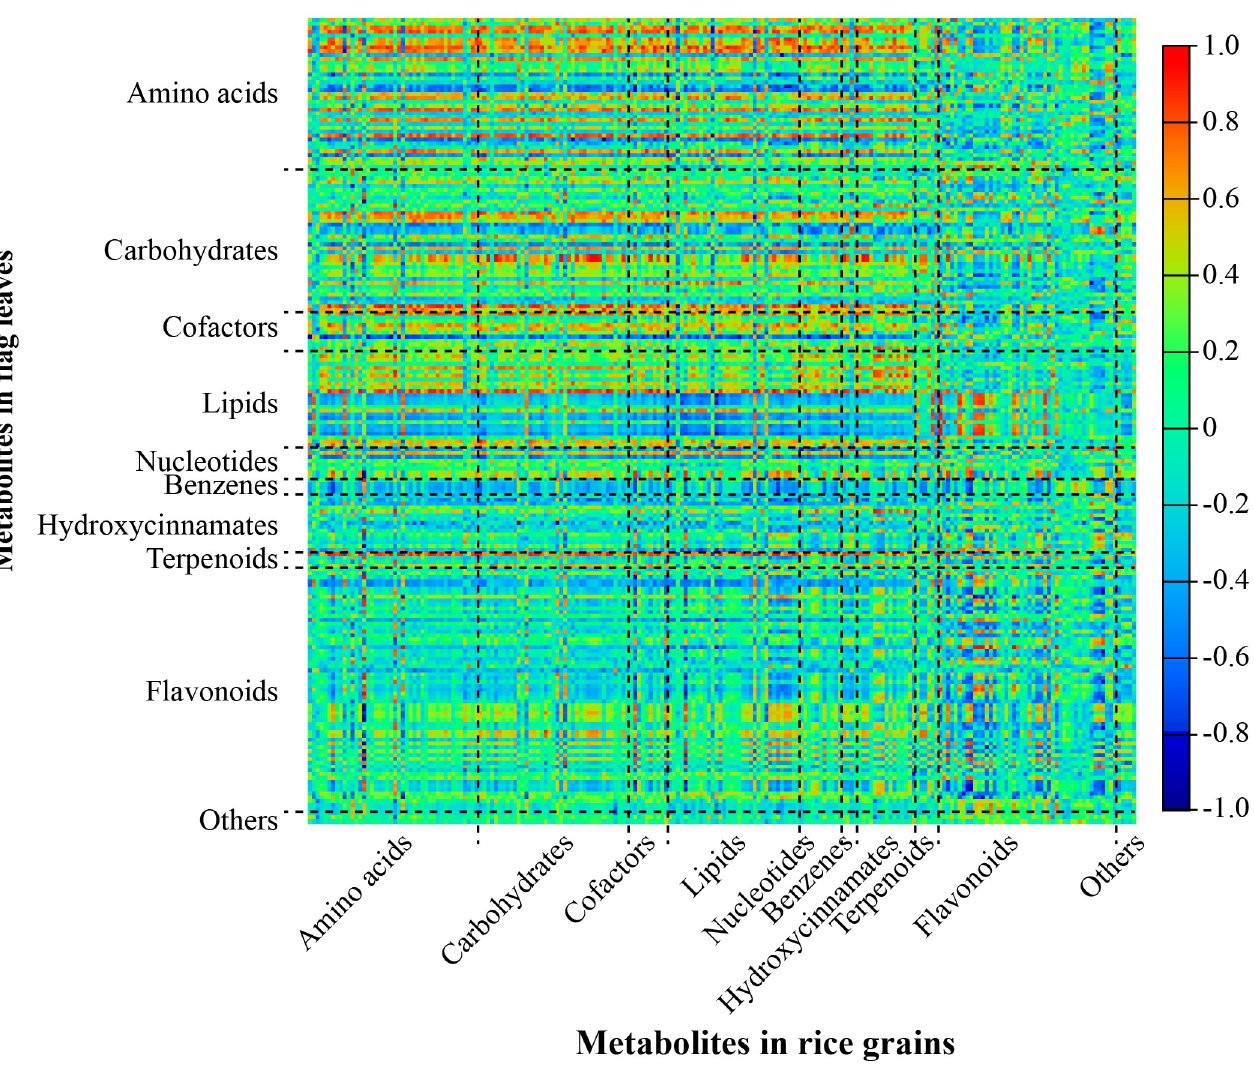
Fig 5. Heatmap of metabolite-metabolite correlation between developing rice seeds and flag leaves. Rectangles represent Pearson correlation coefficient ( r ) values of metabolite pairs (see correlation color key).